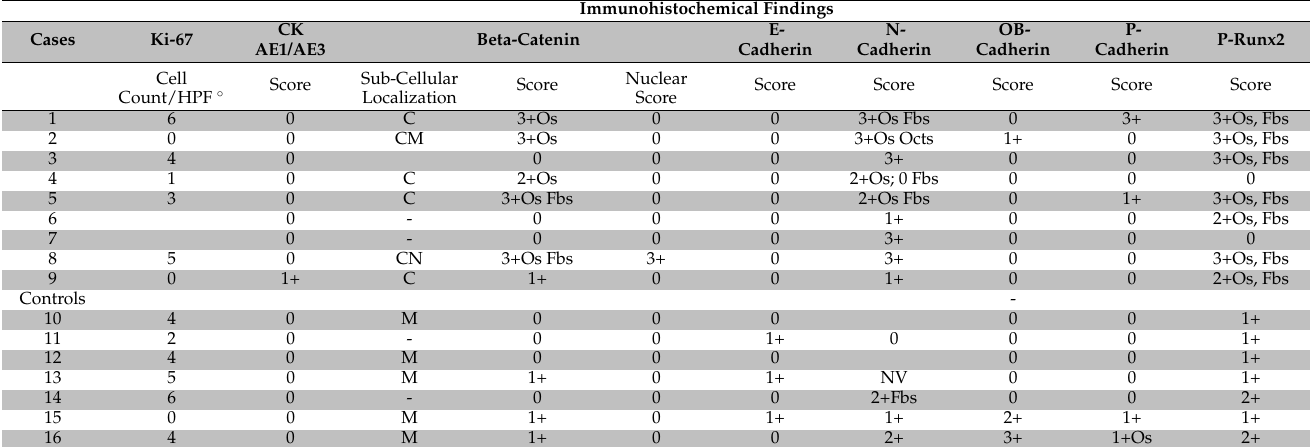
Table 2. TMA based immunohistochemical findings in fibro-osseous lesions of the